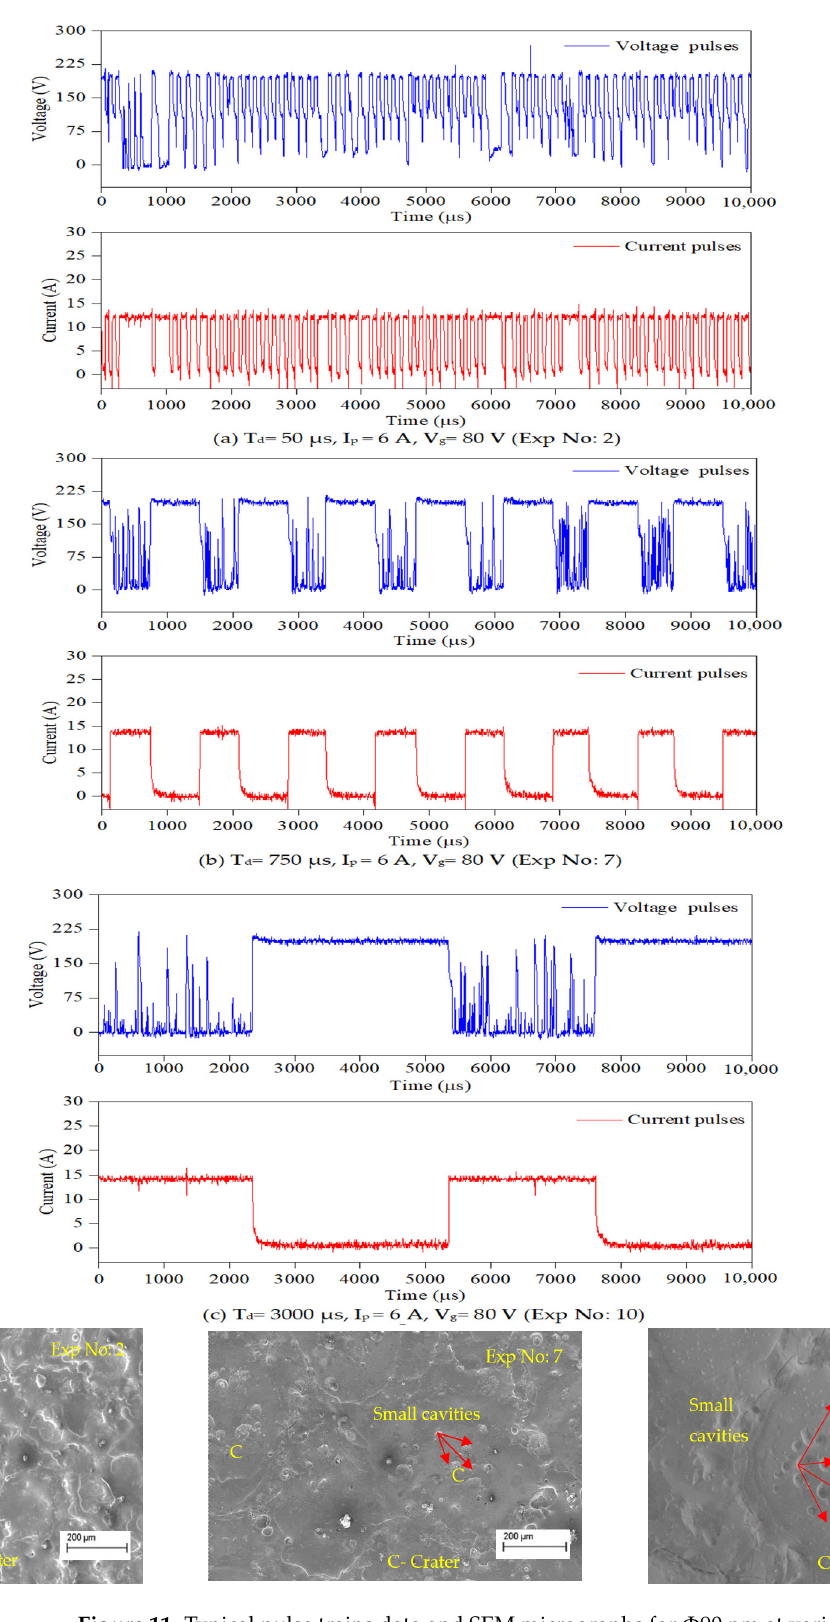
Figure 10. Typical pulse trains data and SEM micrographs for Φ40 μm at various discharge dura- tions (C-crater, PD-partial discharge).